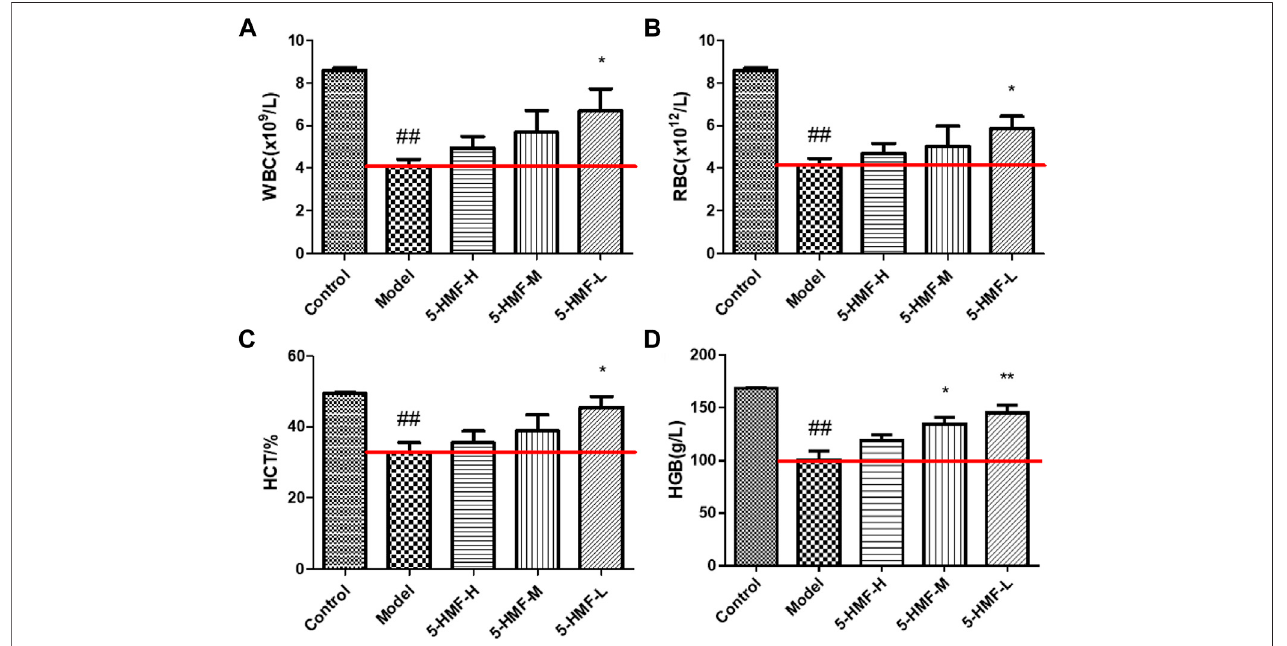
FIGURE 1 | The blood parameters of rats in the control and model groups treated with saline and different doses of 5-HMF. (A) The level of WBC. (B) The level of RBC. (C) ThelevelofHGB. (D) ThelevelofHCT.EachvaluerepresentsthemeanSD( n (cid:1) 8); # p < 0.05and ## p < 0.01,comparedwiththecontrolgroup; *p < 0.05and **p < 0.01, compared with the model